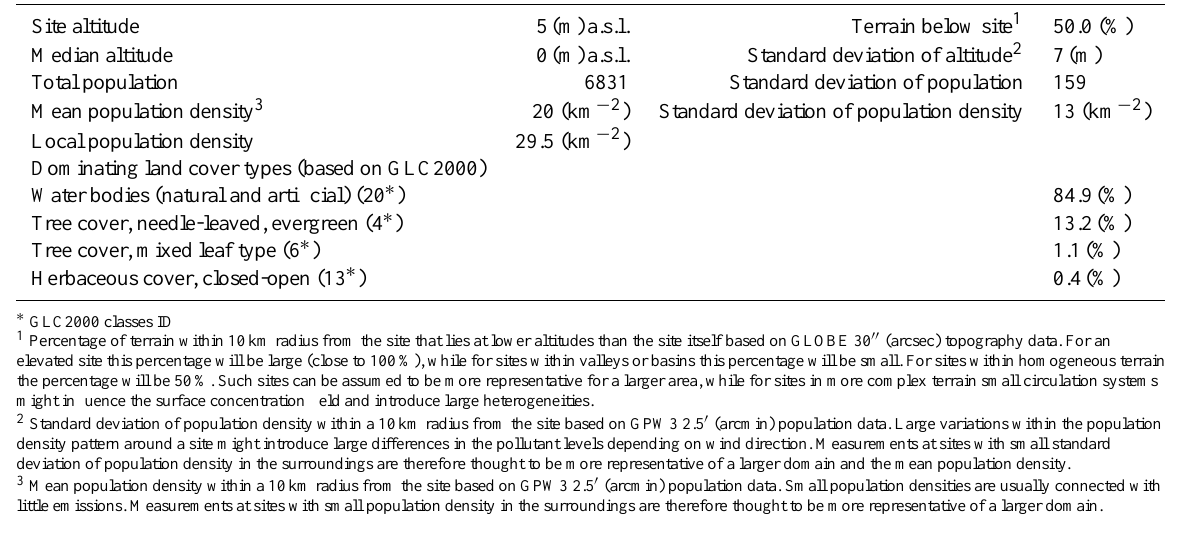
Figure 1. (a) Map of the observation site, Preila (indicated by the red mark). Nearest major cities are Klaipeda (40km north) and Kaliningrad (90km south), (b) Environmental pollution research station Preila and site surroundings (c) . Table 1. Preila site surroundings